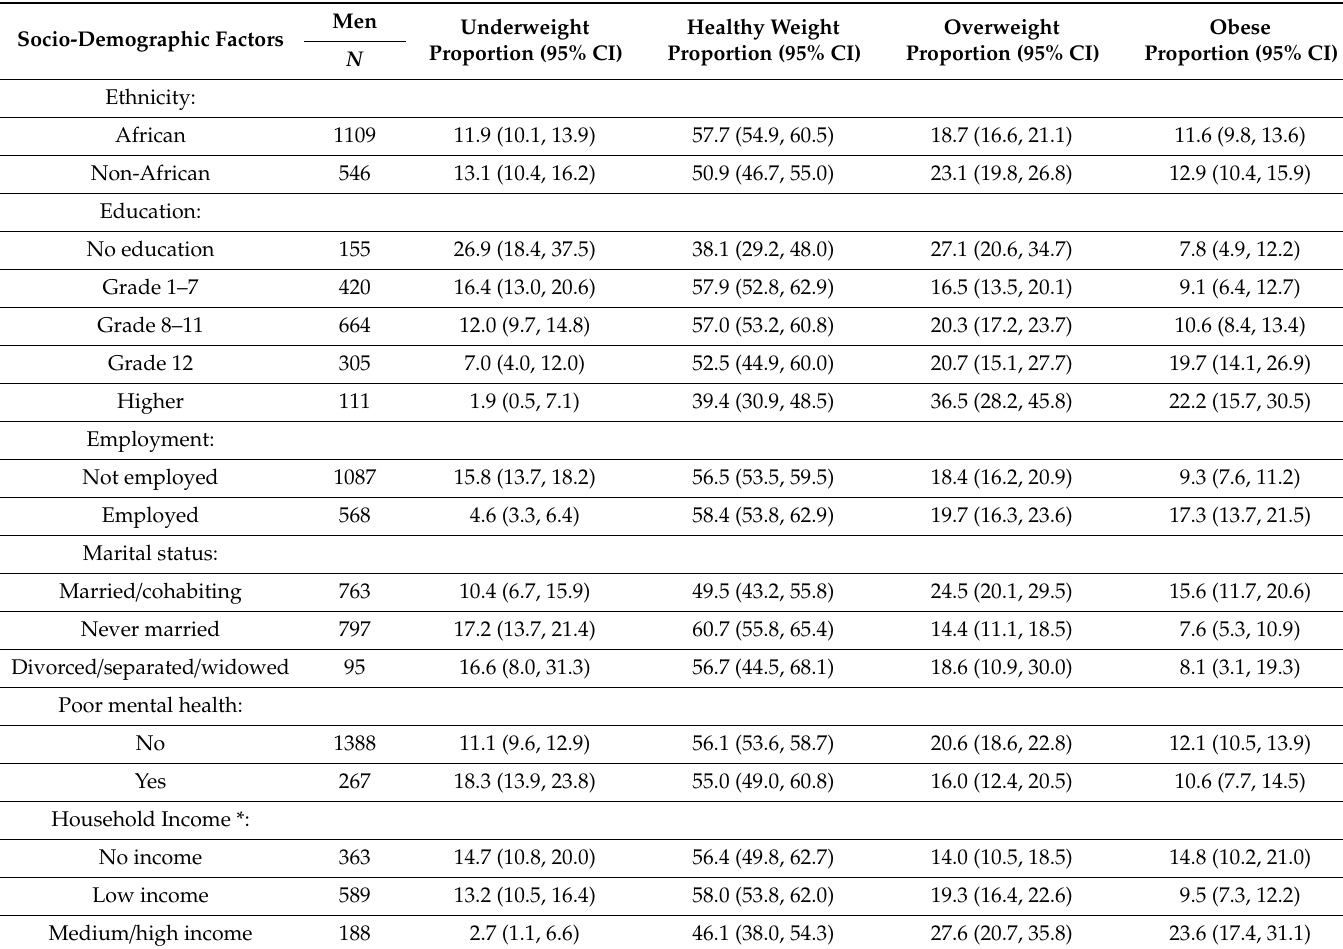
Table 2. Age adjusted proportions of underweight, healthy weight, overweight and obesity among 2254 men from the SANHANES study in 2012; by indicators of socioeconomic